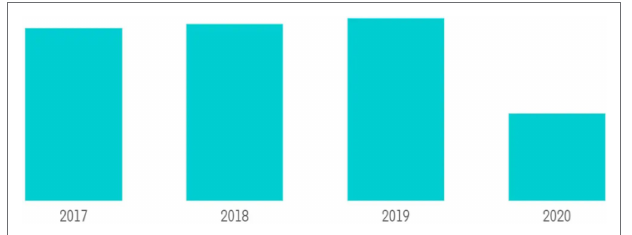
FIGURE 1 | Pakistan’s Hotel Industry Revenue in Millions of Dollars (2017–2020). Source: (Intelligence,